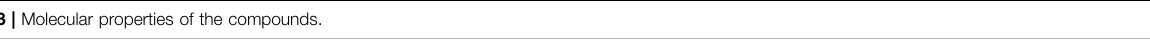
TABLE 3 | Molecular properties of the compounds.